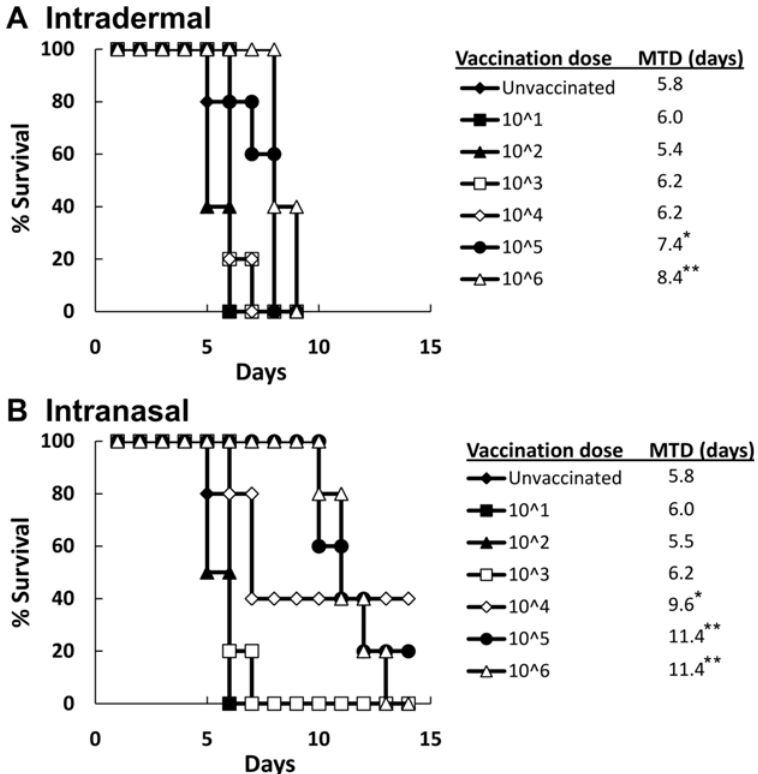
Figure 3. Survival of mice vaccinated with Schu S4 D purMCD and challenged i.n. with 500 CFUs of wild-type Schu S4. Mice (n=5) were vaccinated i.d. (A) or i.n. (B) with 10-fold serial dilutions of Schu S4 D purMCD ranging from 10 to 10 6 CFUs. 21 days post-vaccination, mice were challenged i.n. with 500 CFUs of wild-type Schu S4. The survival of mice was then monitored for 14 days. Vaccination dose is listed in CFUs, and mean time-to-death was calculated for each dose. Asterisks indicate vaccinating doses at which MTD was significant compared to unvaccinated mice (* P , 0.05, ** P , 0.001 by log-rank analysis).